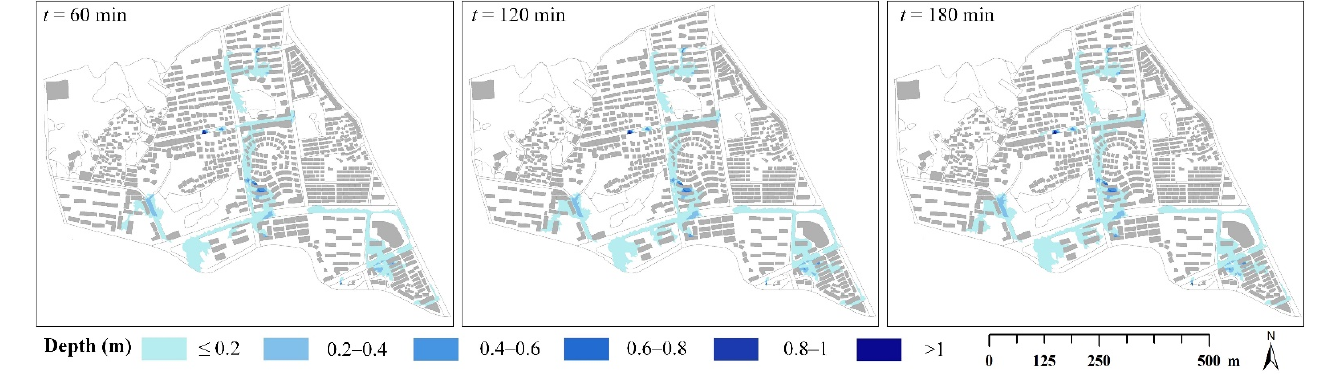
Figure 7. The inundation scene at different durations ( P = 5a and r = 0.4).